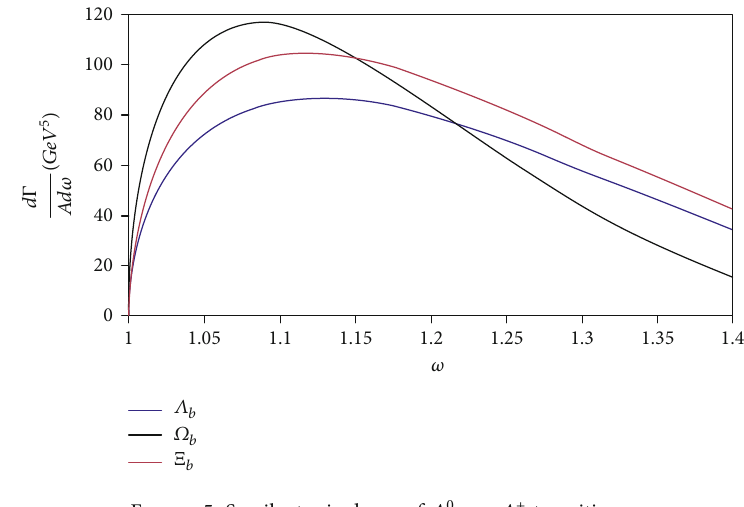
Figure 5: Semileptonic decay of Λ 0